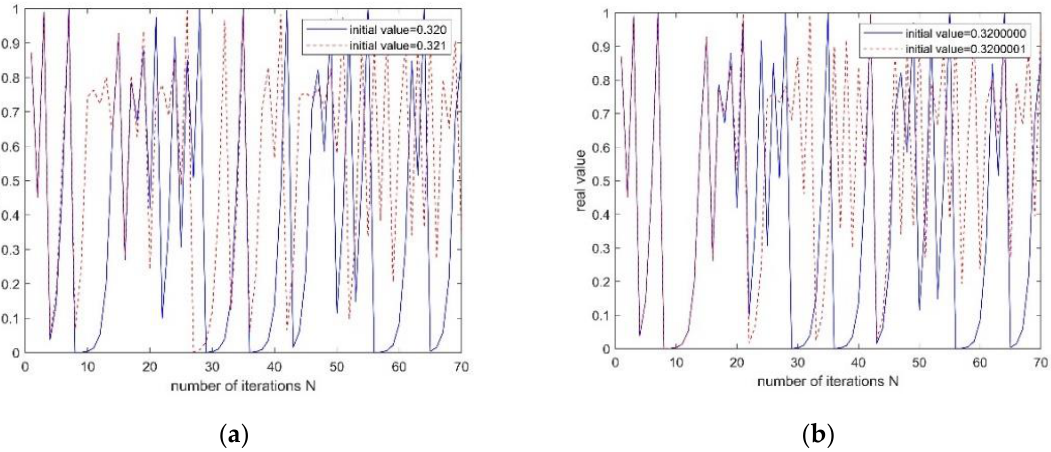
Figure 6. The simulation curve of the initial value sensitivity of the chaotic sequence, in which ( a ) the initial value of the system is 0.320 and 0.321 and ( b ) are 0.3200000 and 0.3200001.